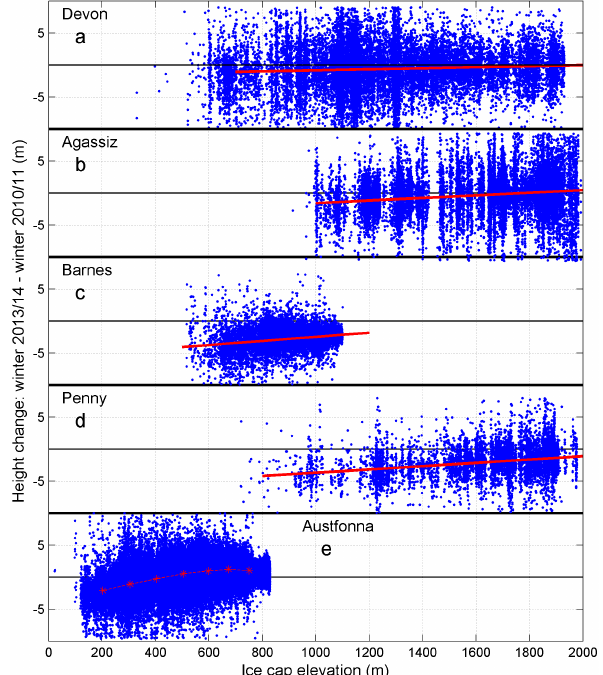
Figure 9. Height loss between the winter of 2010/11 and the winter of 2013/14 as a function of elevation for the five ice caps. Red lines are a linear fit to the data except for Austfonna (e) where the points are averages over 100m elevation bands.